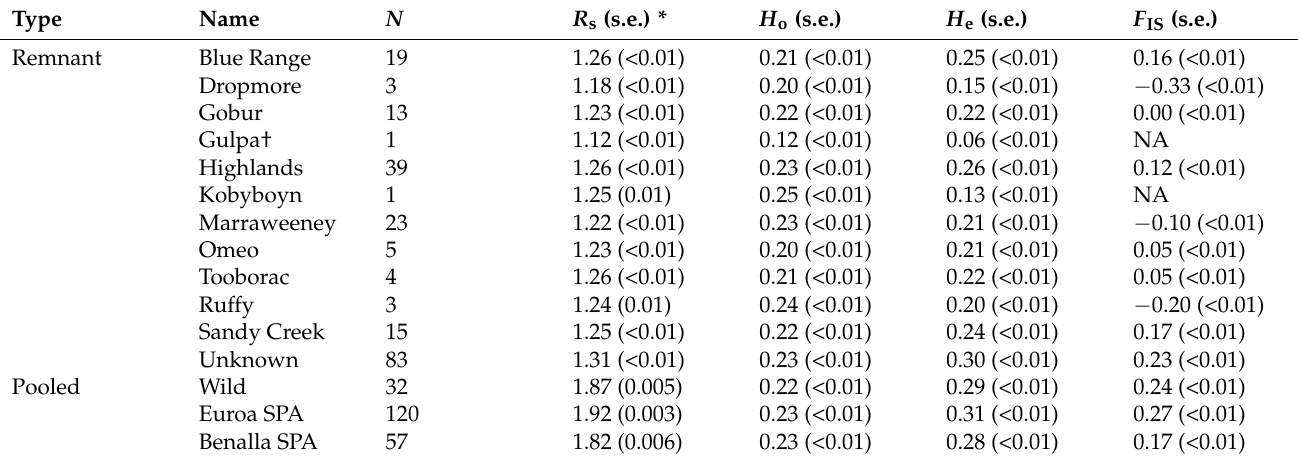
Table 2. Collection details and SNP genetic diversity indices of Banksia marginata SPAs and presumed local wild seed